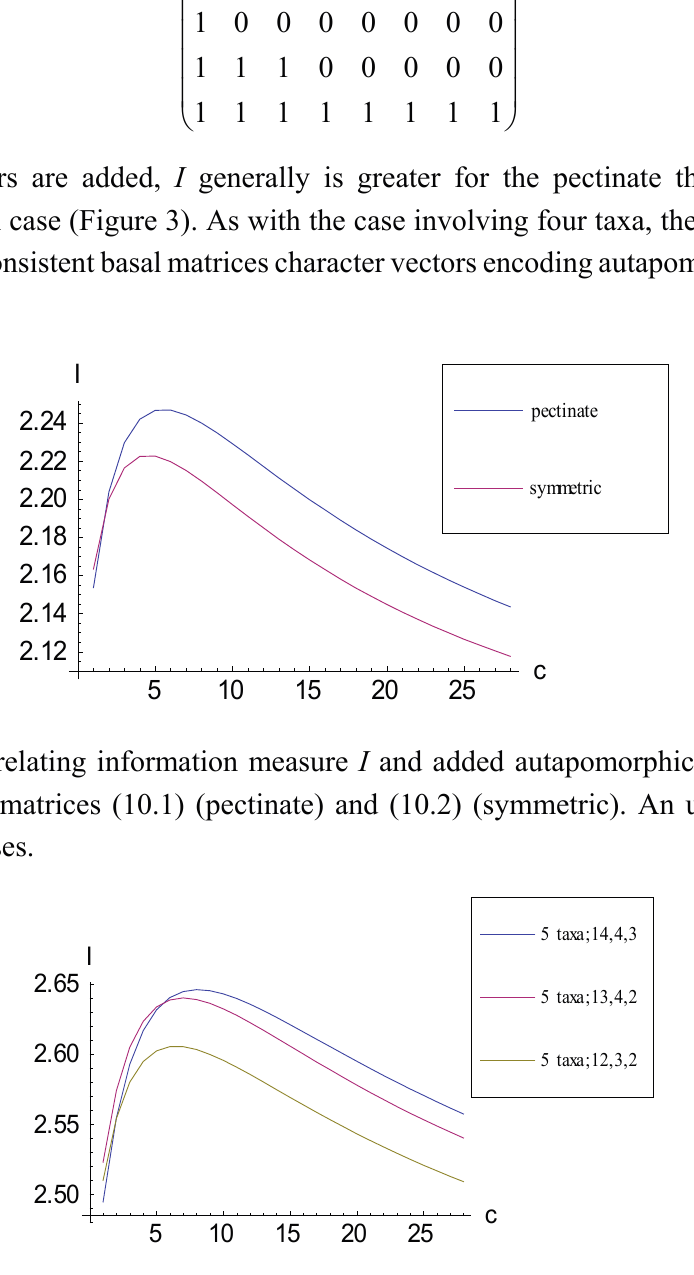
Figure 4. Plots relating information measure I and added autapomorphic characters c for consistent basal matrices (11.1)–(11.3). An upper bound to I exists in all three